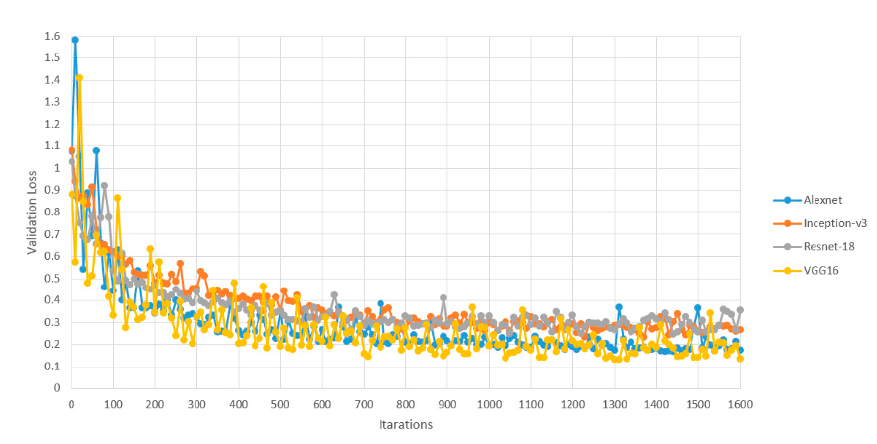
Figure 9. Validation loss iteration change graph.